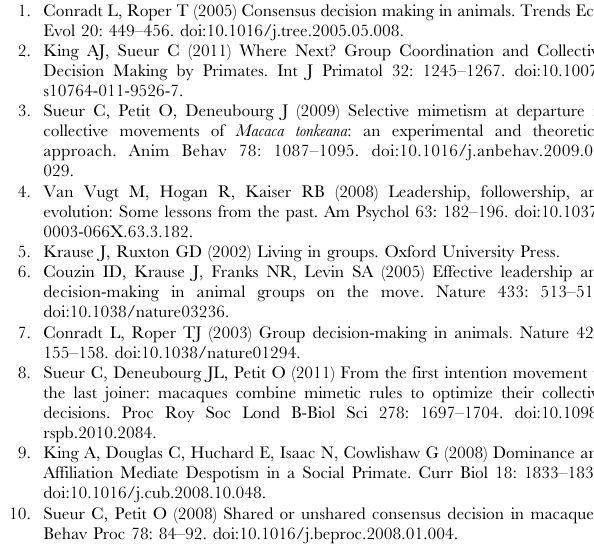
Figure S1 Graph representation of social networks. (a) Erdos-Renyi random network and (b) chain network. Squares represent individuals. C is the central individual, c 1–9 are non central individuals. Lines are relationships between individuals: the thicker the line, the stronger the relationship. The size of square represents the eigenvector centrality: the bigger the square, the higher the centrality. (TIF) Figure S2 Mean departure latency according to the rank for each social network. (TIFF) Figure S3 Latencies’ distribution of joiners when the initiator is the central individual (blue) and when it is a non central individual (red) for each social network. (TIFF) Table S1 Relationships, eigenvector centrality for the central individual C and the non central individuals c , and centrality index for the random network and the chain network. Table S2 Detailed results for Dunn’s multiple